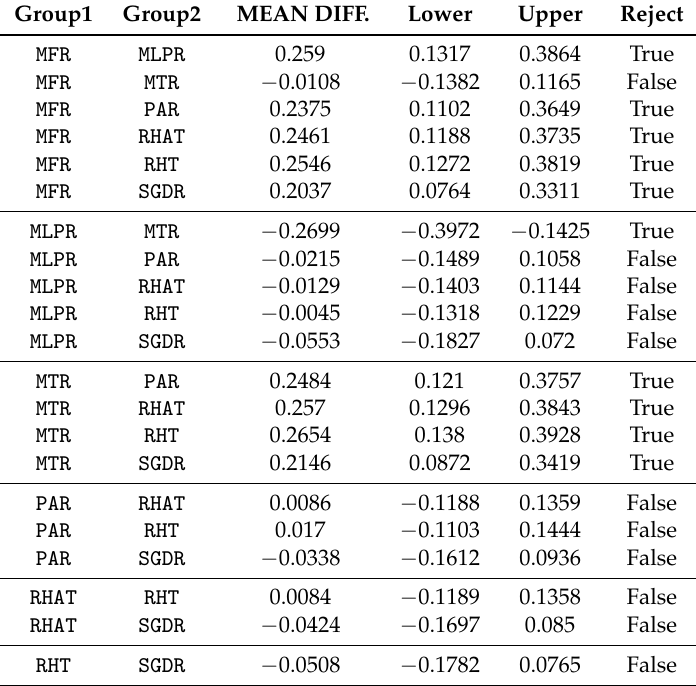
Table 12. Results of the Tukey’s range test for experiment 1.